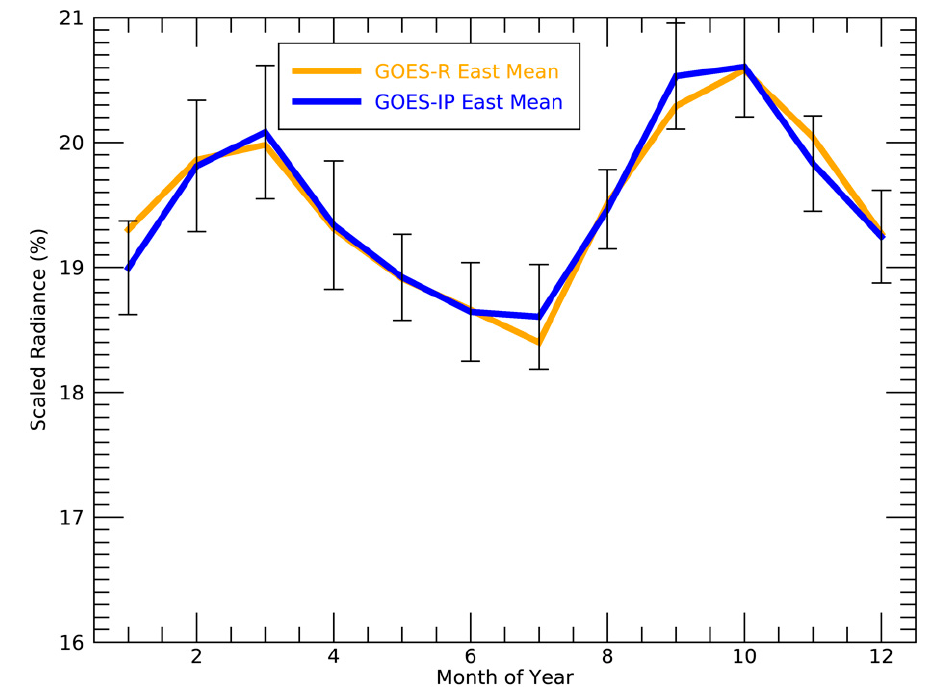
Figure 3. The annual cycle of FD scaled radiances for GOES-East. The orange curve is the annual cycle for GOES-R (GOES-16) and is used as the reference values for calibrating GOES-IP East data. The blue curve is the resulting annual cycle from the calibrated GOES-IP East data. The error bars show the standard deviation of the monthly values for the entire GOES-IP record. These standard deviations are assumed to be representative of the GOES-R reference.